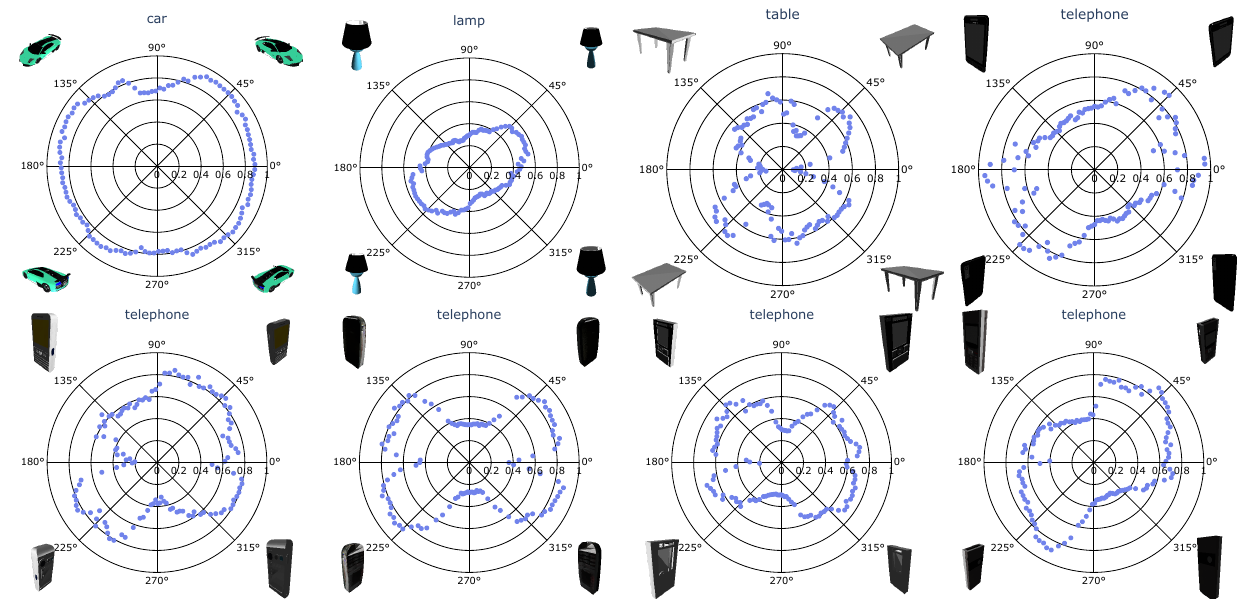
Figure 9. Polar plot indicating single-view reconstruction quality. IoU is shown on the radial axis, viewpoint azimuth on the angular